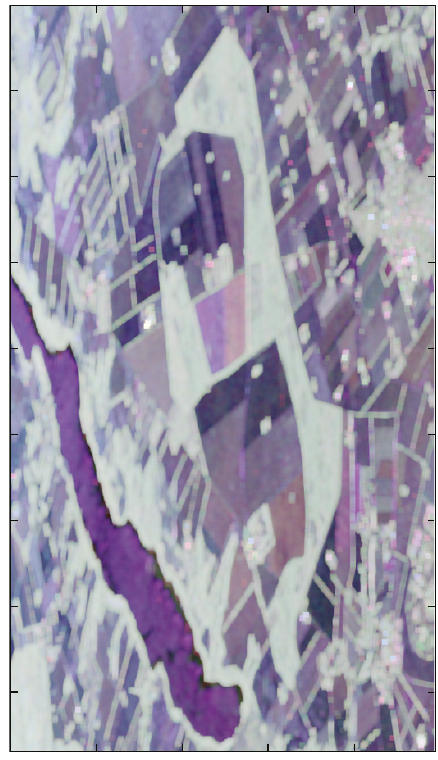
Figure 13: Foulum image segmentation example based upon modelled parameters. 16-class discrete mixture of multivariate Gaussian clustering on 6D feature